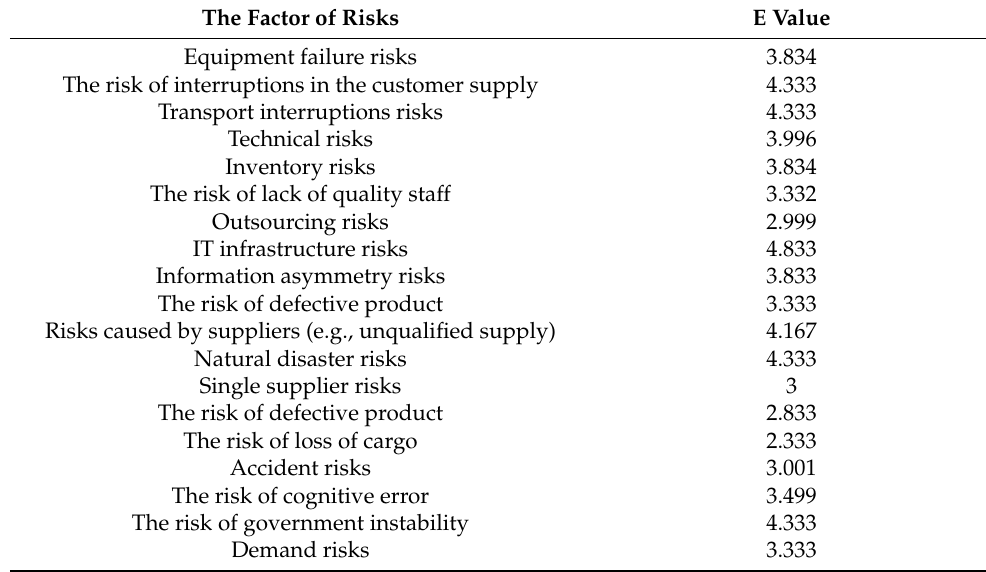
Table 5. Evaluation of risk factors.